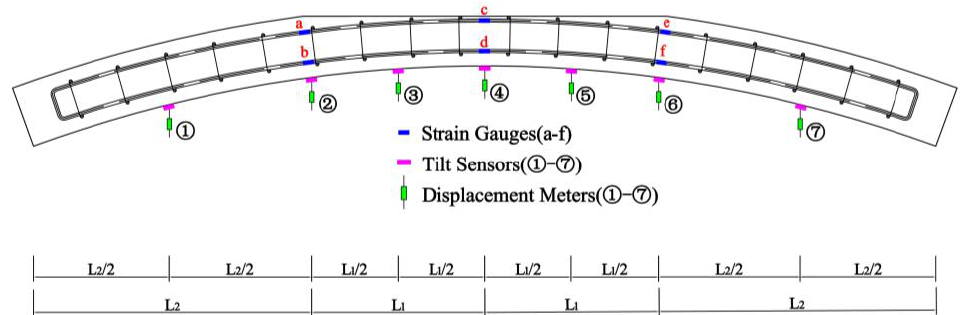
Figure 4. Scheme of the measuring points.